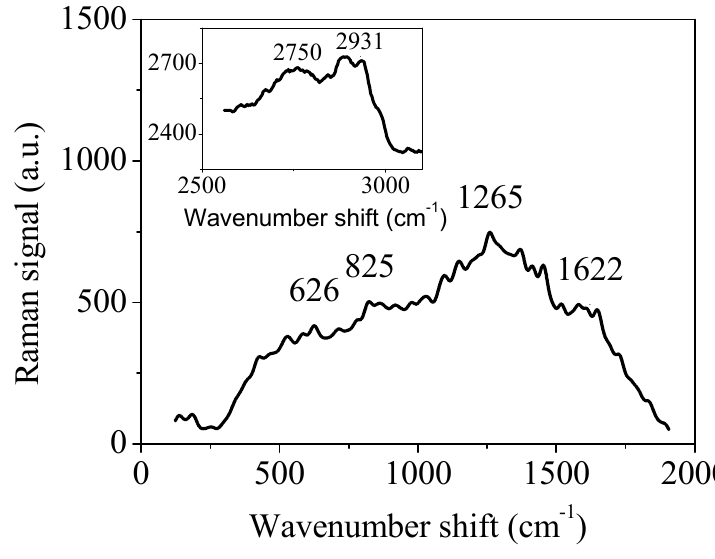
Figure 1. Raman spectrum measured on a fruit juice sample of type A (apple juice). The investigated wavenumber shift range varies between 200 and 3200 cm -1